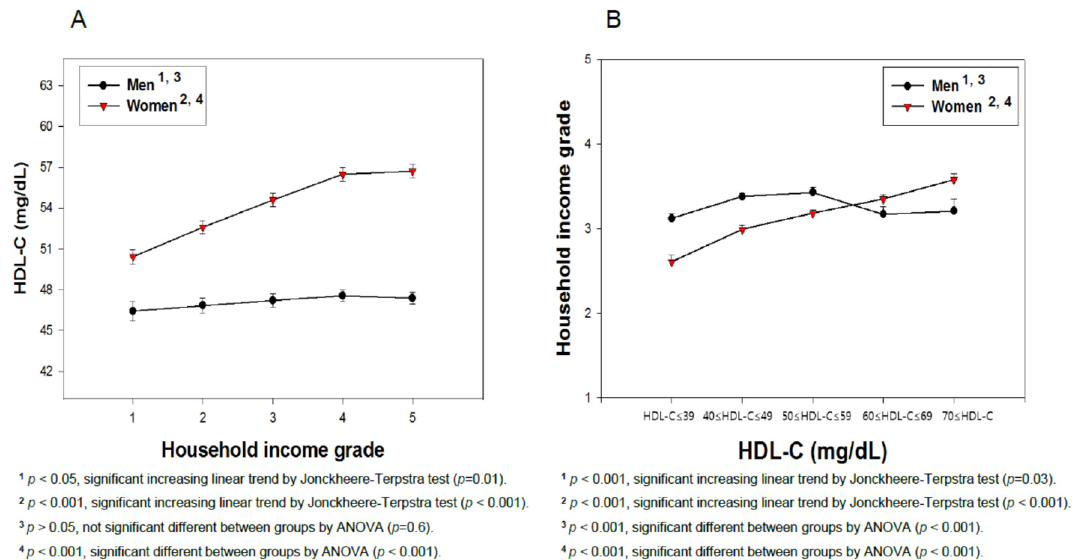
Figure 4. Mean high-density lipoprotein cholesterol (HDL-C) levels according to the household income grade in men and women ( A ). The mean household income grade levels according to the high-density lipoprotein cholesterol (HDL-C) category in men and women ( B ). KNHANES 2017. The data are expressed as the mean ± SEM (Standard Error of the Mean).